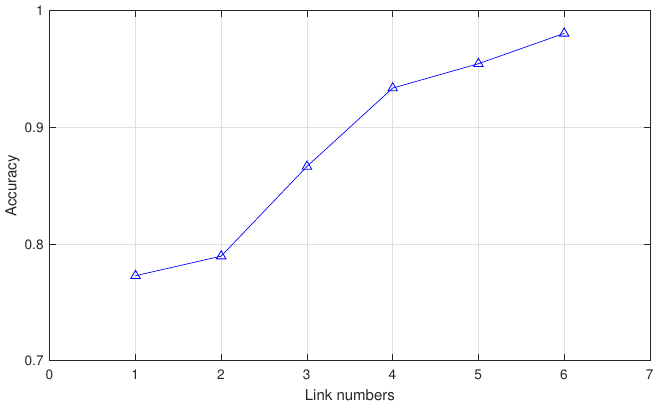
Figure 12. Comparison of the impact of different numbers of